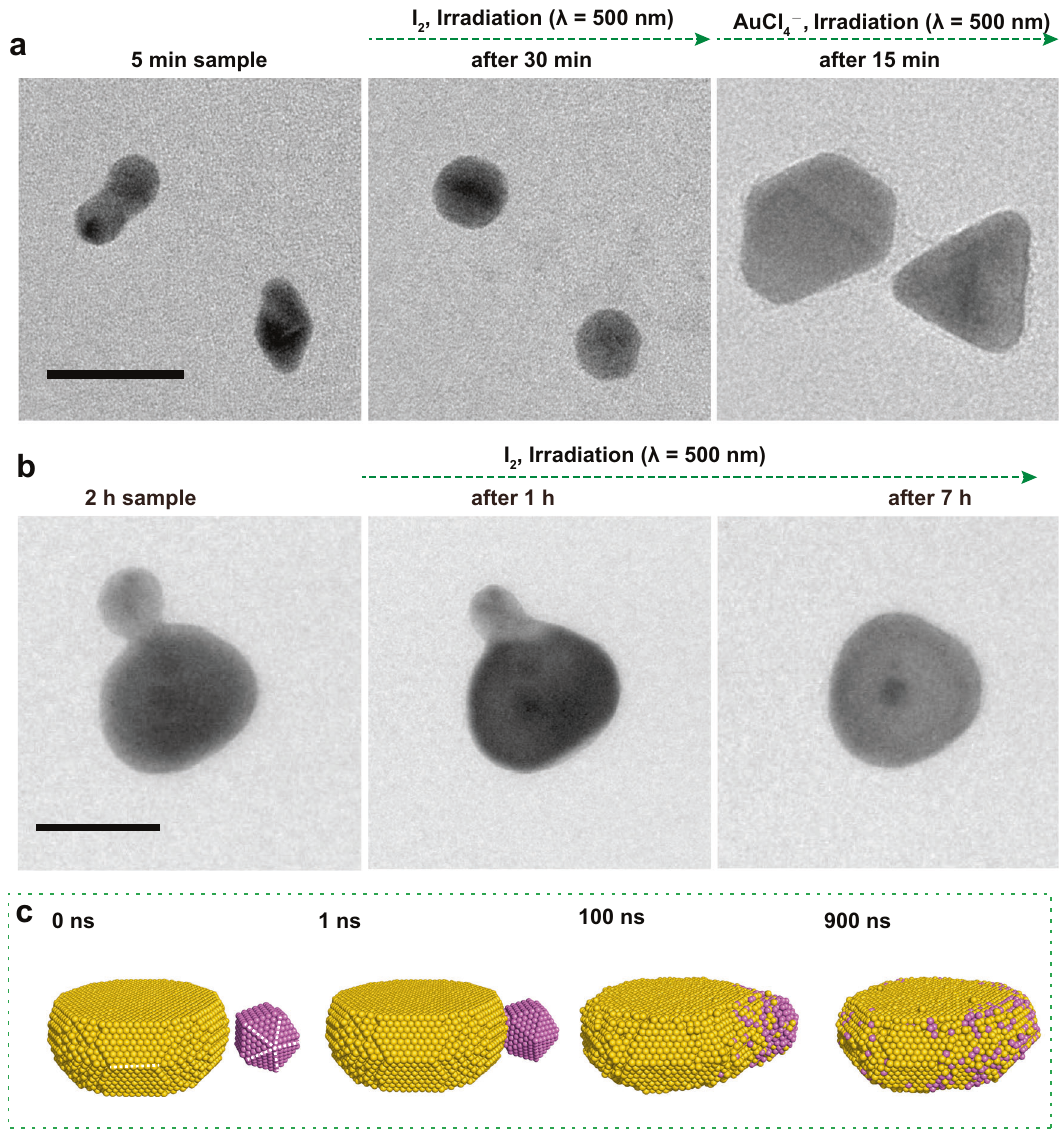
Fig. 4 Evolution of nanoparticles coalescence process by TEM tracking and MD simulations. a TEM images of the tracking of nanoparticle aggregates conversion process. The fi rst reaction is to put the TEM chip in the real conversion solution for 30 min with 500 nm light irradiation. The second reaction is to further put the TEM chip in a solution containing 4.84 ml ultrapure H 2 O, 0.50 ml PVP (K30, 5 mg/ml), 0.50 ml CH 3 OH, and 0.16 ml HAuCl 4 (25 mM) for 15 min under 500 nm light irradiation. The scale bar indicates 20 nm. b TEM images of nanoparticle-nanoplate coalescence intermediate structure to nanoplate conversion process. The scale bar indicates 50 nm. c Snapshots of the coalescence trajectory of a larger Au nanoplate (gold) and penta twinned structure